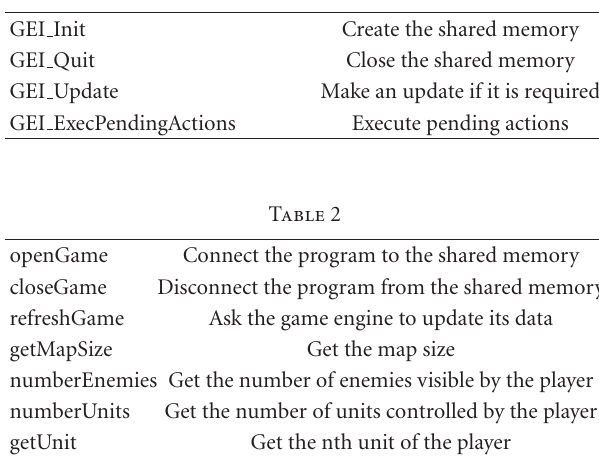
Figure 6: Kernel